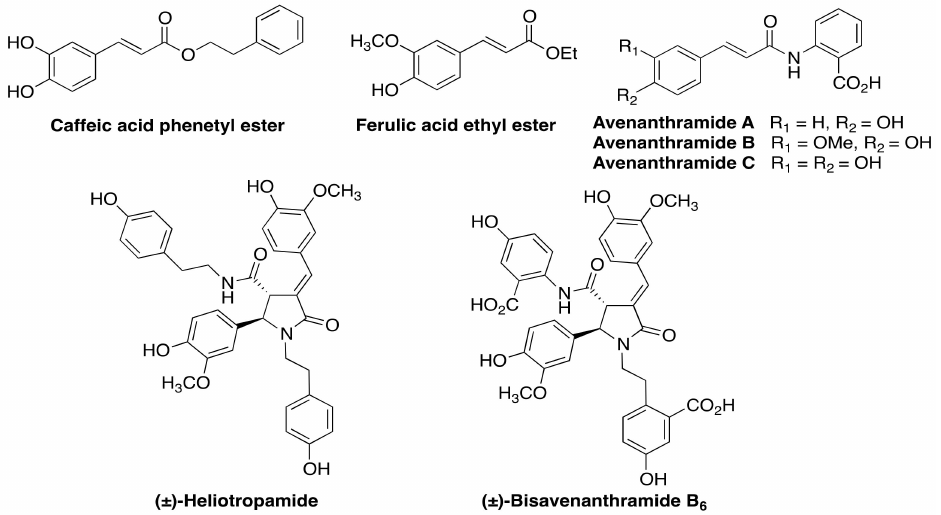
Figure 1. Some natural cinnamic acid derivatives with antioxidant